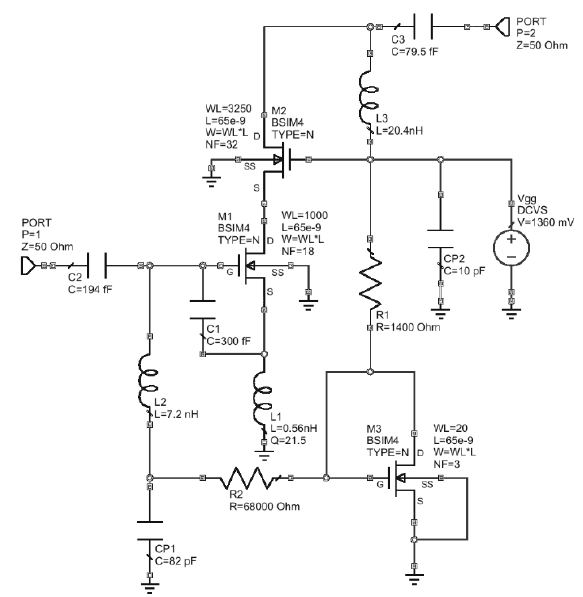
Figure 16. Complete LNA schematic circuit.